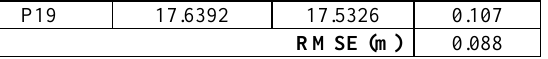
Table 12. RMSE value from the comparison of Mean Sea Level from MyGEOID N fitted (H GPS ) with Mean Sea Level from precise levelling (H MSL